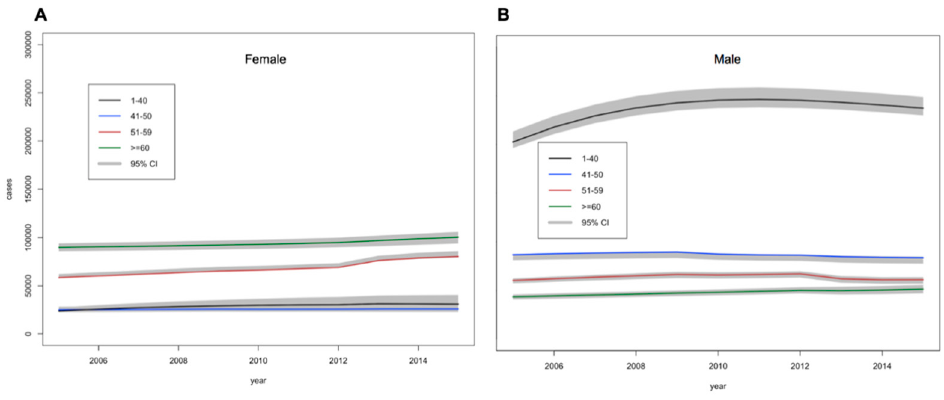
Figure 3. Estimations of the number (95% credible intervals) of ( A ) females and ( B ) males with undiagnosed diabetes between 2005 and 2015 by age.